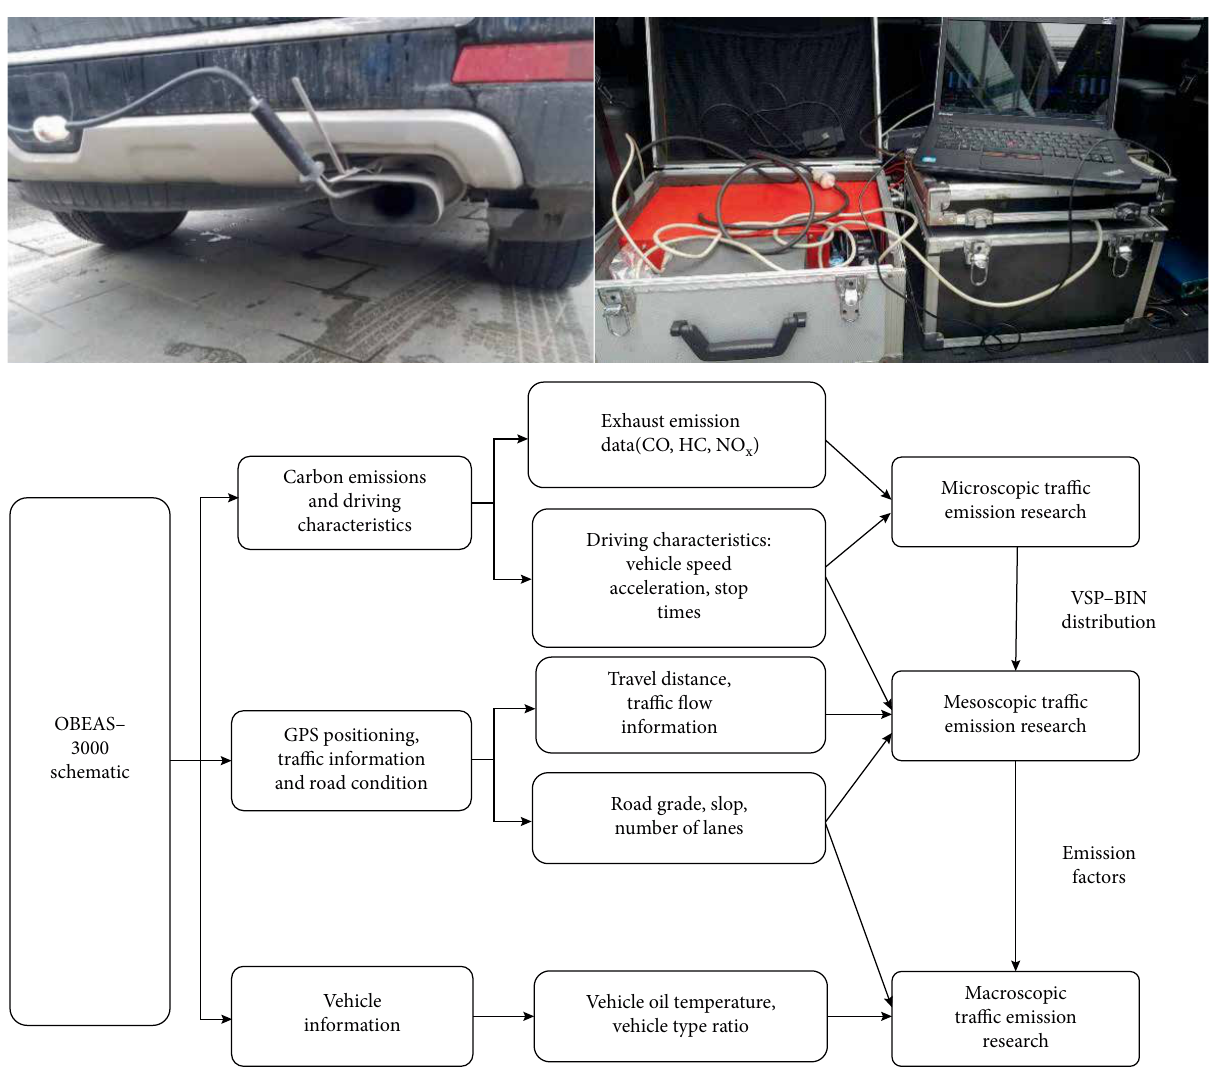
Figure 2: The experiments, emissions testing setup and schematic.